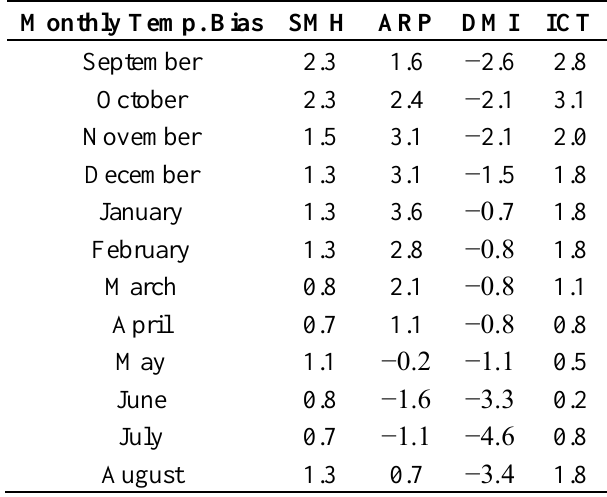
Figure 4. Seasonal variability of monthly air temperature (observed and RCM outputs). Table 2. Regional climate model (RCM) error in monthly average temperature (°C)